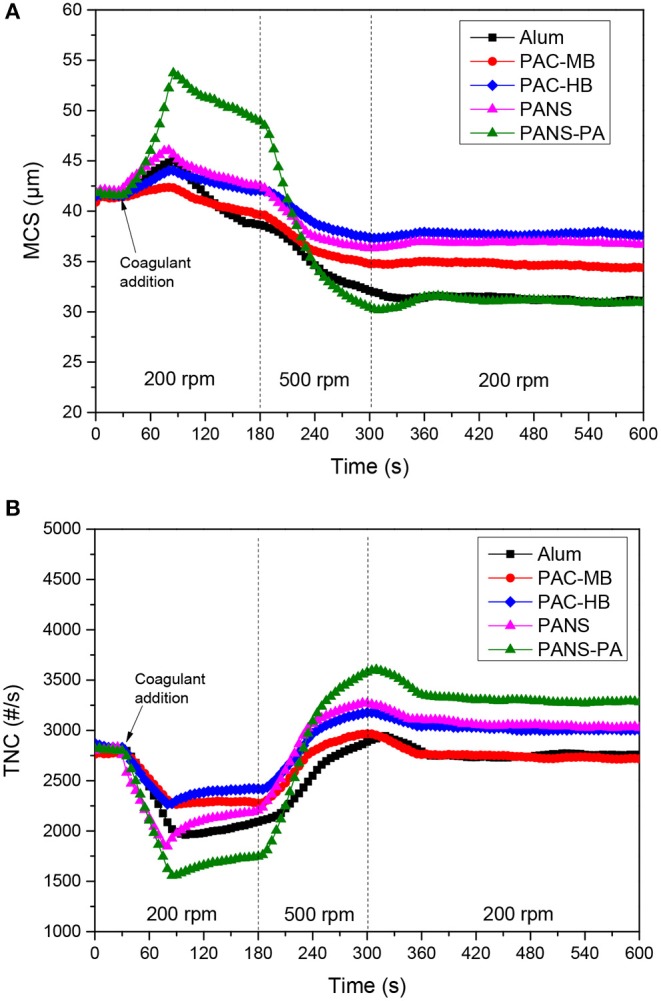
(A) MCS and (B) TNC at 250 mg/L Al2O3 coagulant vs. time in flocculation-deflocculation-reflocculation studies.